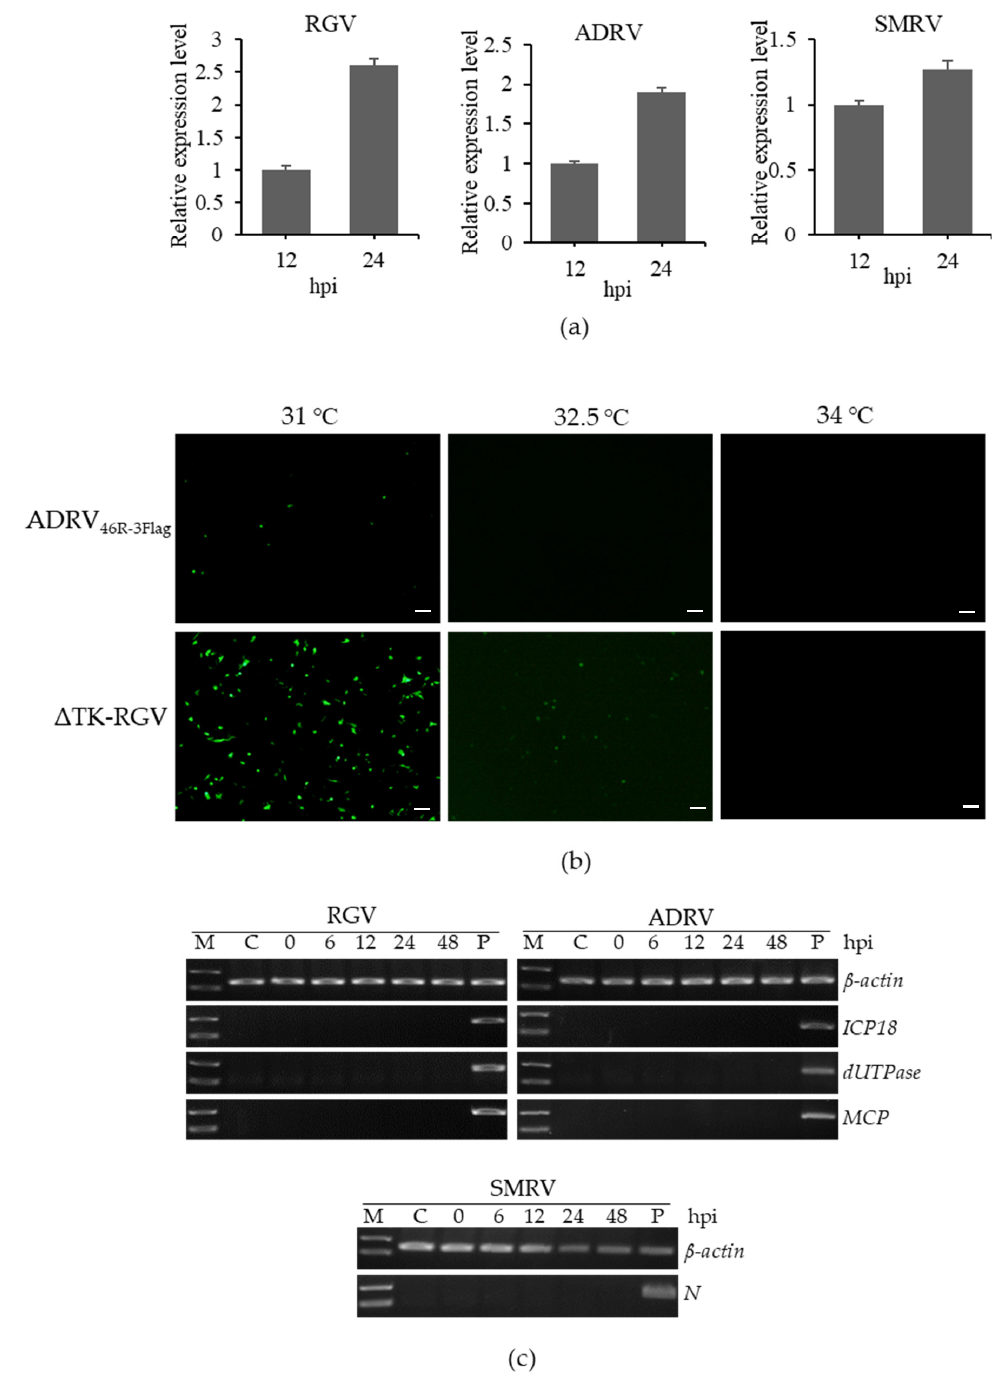
Figure 5. Detection of the infectivity of the aquatic animal viruses in BHK-21 cell. ( a ) Gene expression of the five viruses detected by RT-qPCR. The three viruses, RGV, ADRV, and SMRV, that had gene expression in the cells were shown. ( b ) Fluorescence microscopy observation of the cells infected by ADRV 46R-3Flag and ∆ TK-RGV at different temperatures. The green fluorescence was not observed at the temperatures more than 32.5 ◦ C for ADRV 46R-3Flag and more than 34 ◦ C for ∆ TK-RGV. Bar = 200 µ m. ( c ) RT-PCR detection of the gene expression of RGV, ADRV, and SMRV at 37 ◦ C in BHK-21 cells. Expression of ICP18 , dUTPase , and MCP gene of RGV and ADRV, and N gene of SMRV cannot be detected. ICP18 , dUTPase , and MCP gene are representative genes of different transcription stages of RGV and ADRV. P, positive control. The detection of β -actin was used as internal